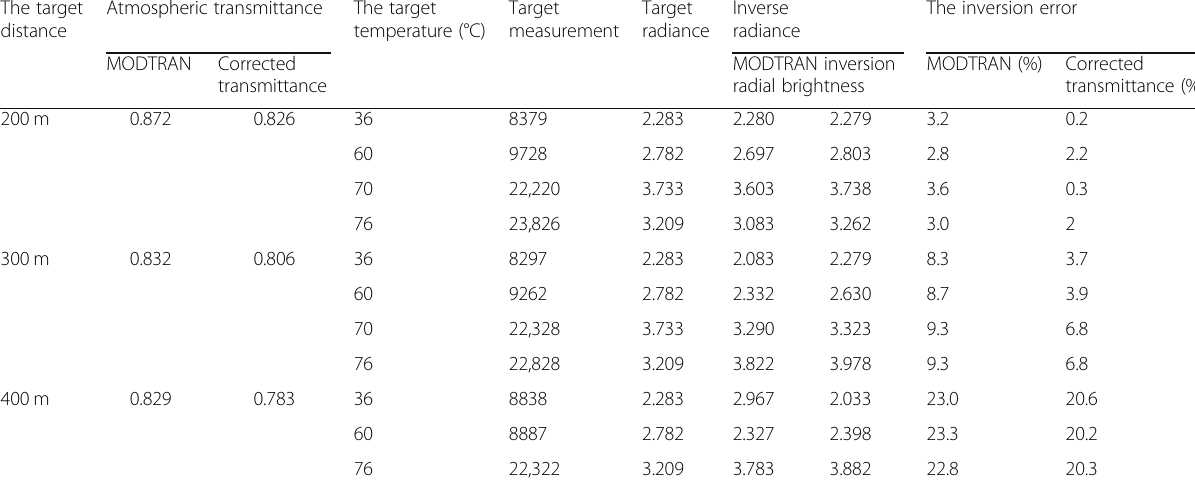
Table 9 Inversion results of atmospheric transmittance after modification when IT = 2 ms The target Atmospheric distance